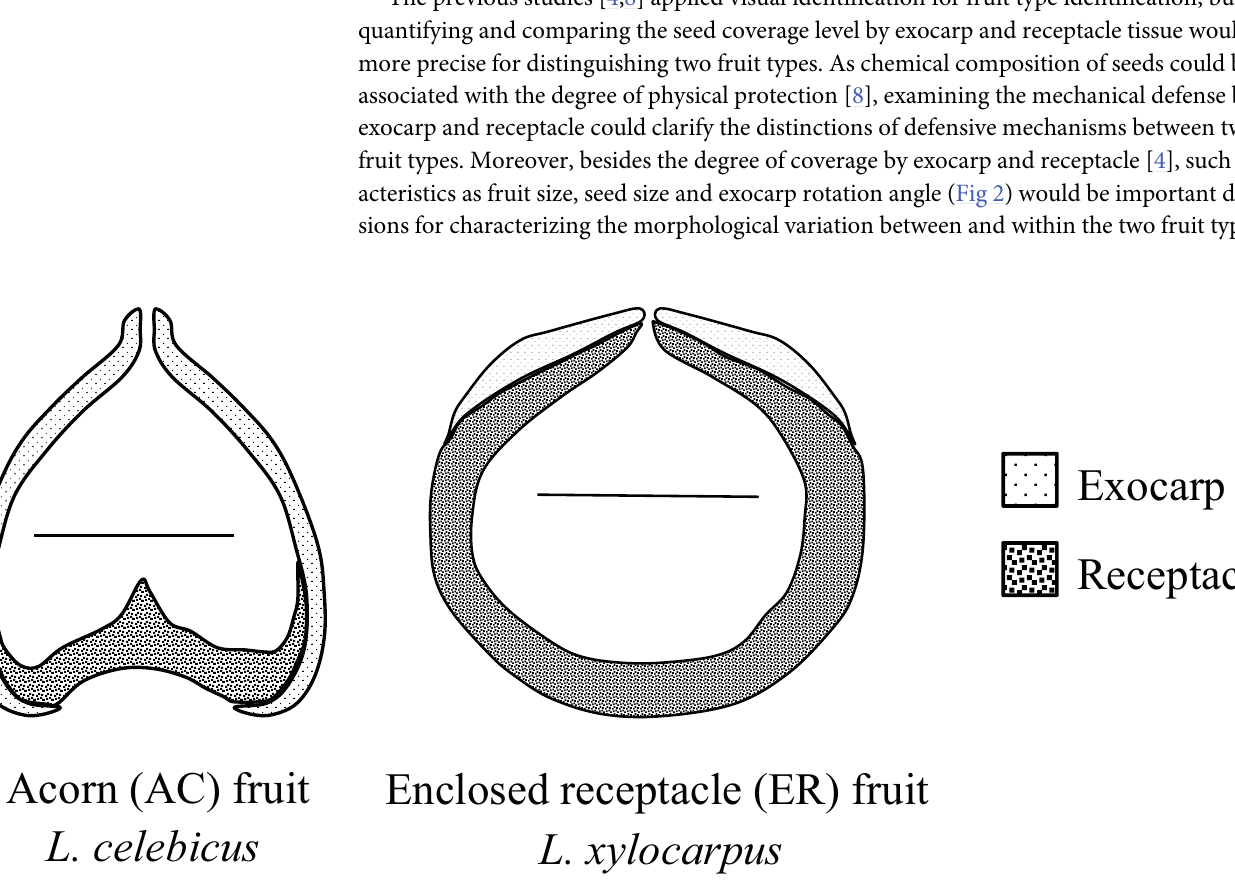
Fig 1. The longitudinal section of two fruit types of Lithocarpus . Bars inside of the fruits represent 1cm size reference.